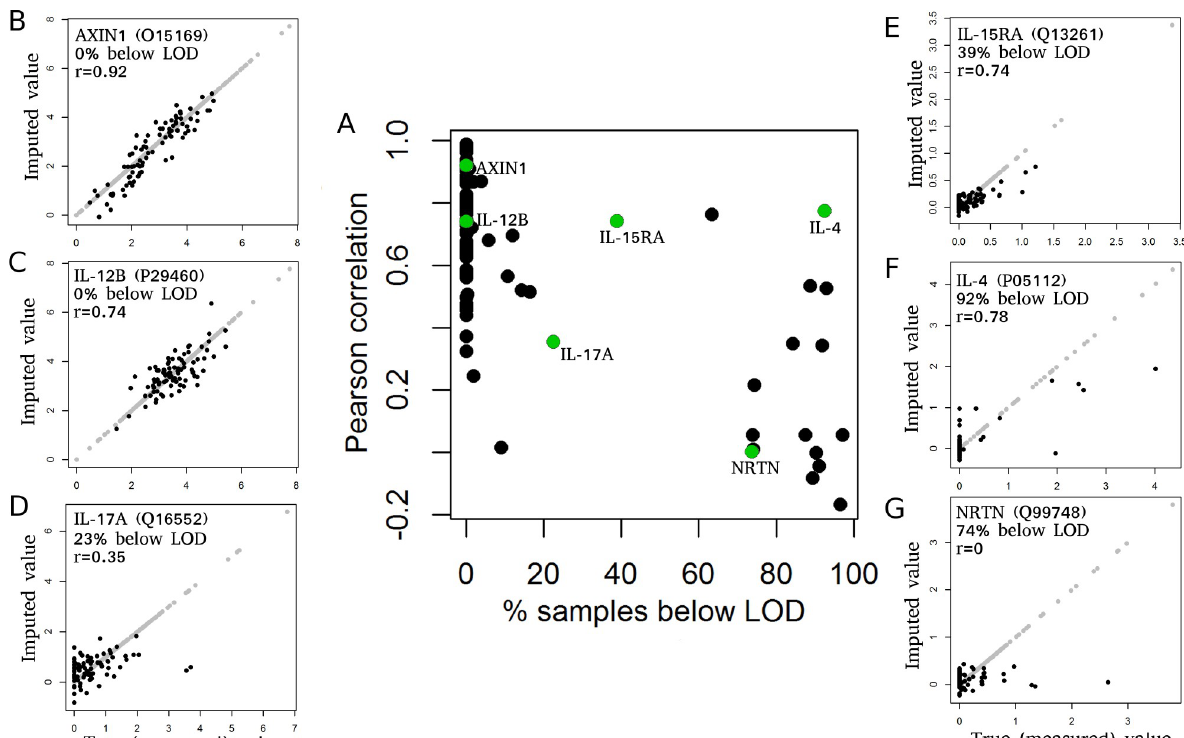
Fig 5. GSimp imputation vs. remeasurement. (A) Pearson correlation between GSimp-imputed and remeasured protein expression values (y-axis) versus fraction of samples below LOD (x-axis) for 91 proteins. The results were overall similar to those based on missForest (Fig 2). (B-G) Scatterplots of remeasured (x-axis) versus imputed (y-axis) values for selected proteins. Protein names, fractions of samples below LOD and Pearson correlation value (r) are provided for each panel. Each dot represents one sample. Black dots represent the imputed and remeasured values. Light gray dots represent all values that did not have to be imputed and are visualized as reference. Scatterplots for all 91 proteins are provided in S9 Fig. The scatterplot of IL-12B (C) revealed no reduction in variance for imputed values, in contrast to the missForest result (Fig 2C).